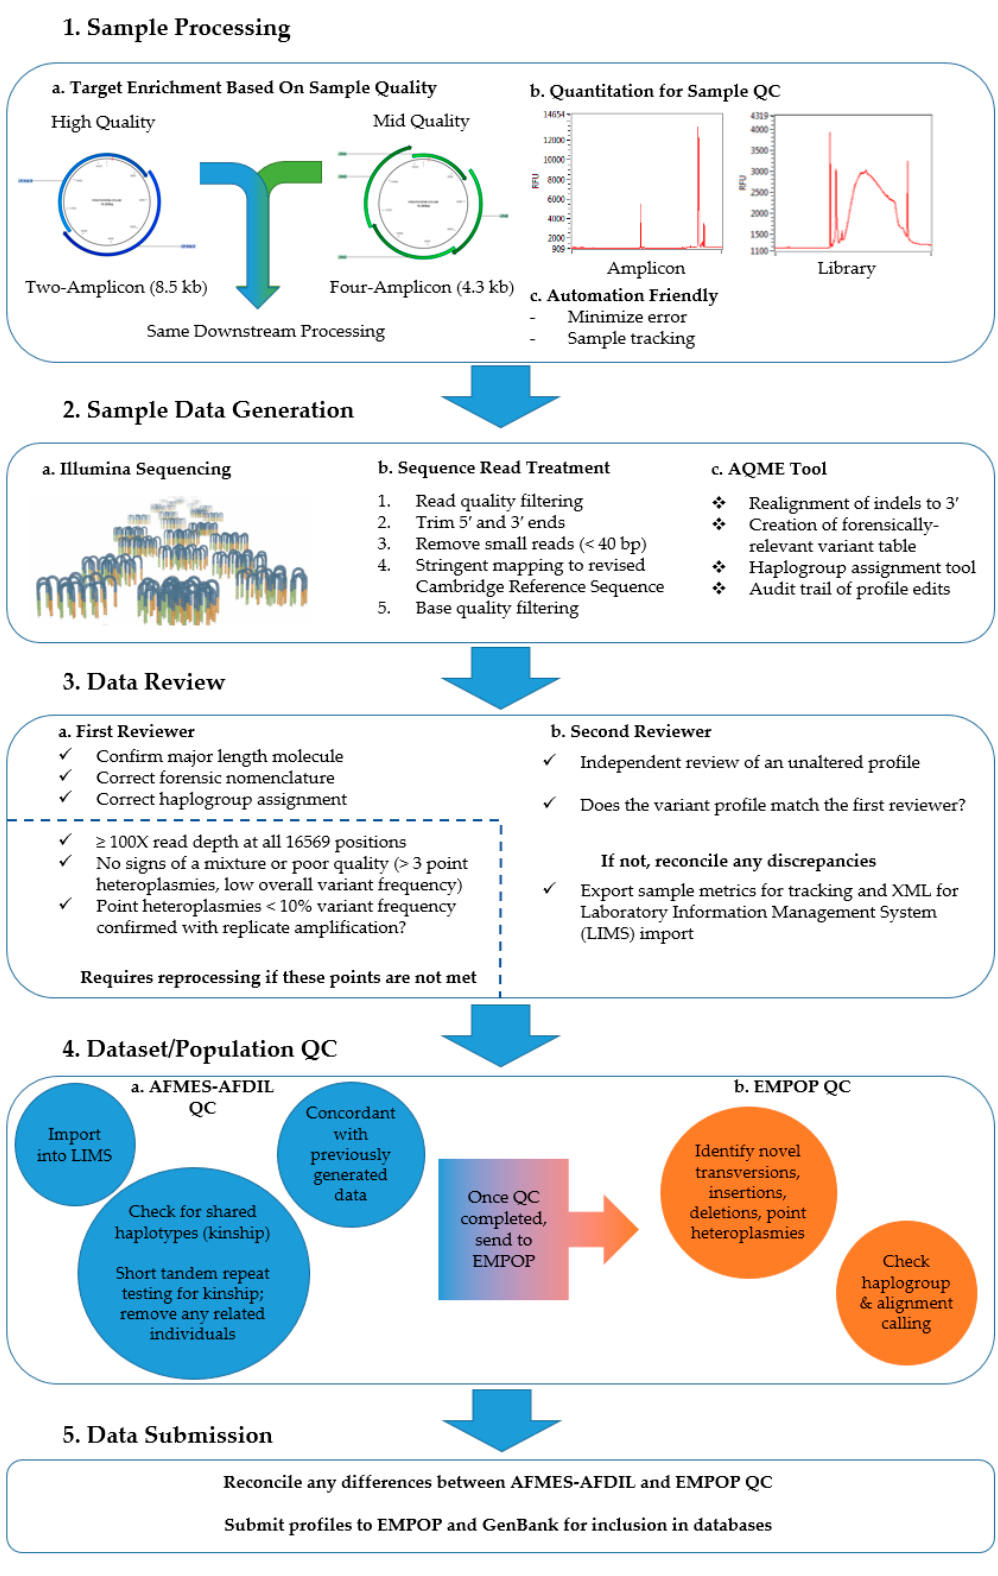
Figure 1. Summary of methods and quality control (QC) process for the generation of platinum-quality mitochondrial genomes. AFMES-AFDIL = Armed Forces Medical Examiner System’s Armed Forces DNA Identification Laboratory; EMPOP = The European DNA Profiling Group (EDNAP) mtDNA Population Database.